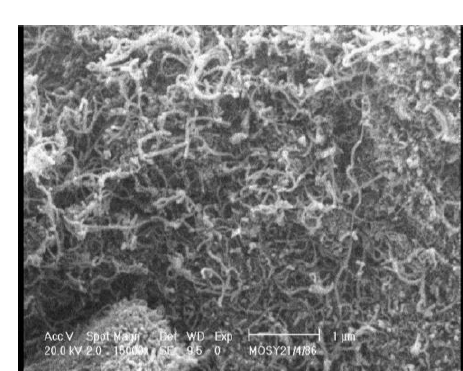
Figure 2. SEM of MWCNTs.